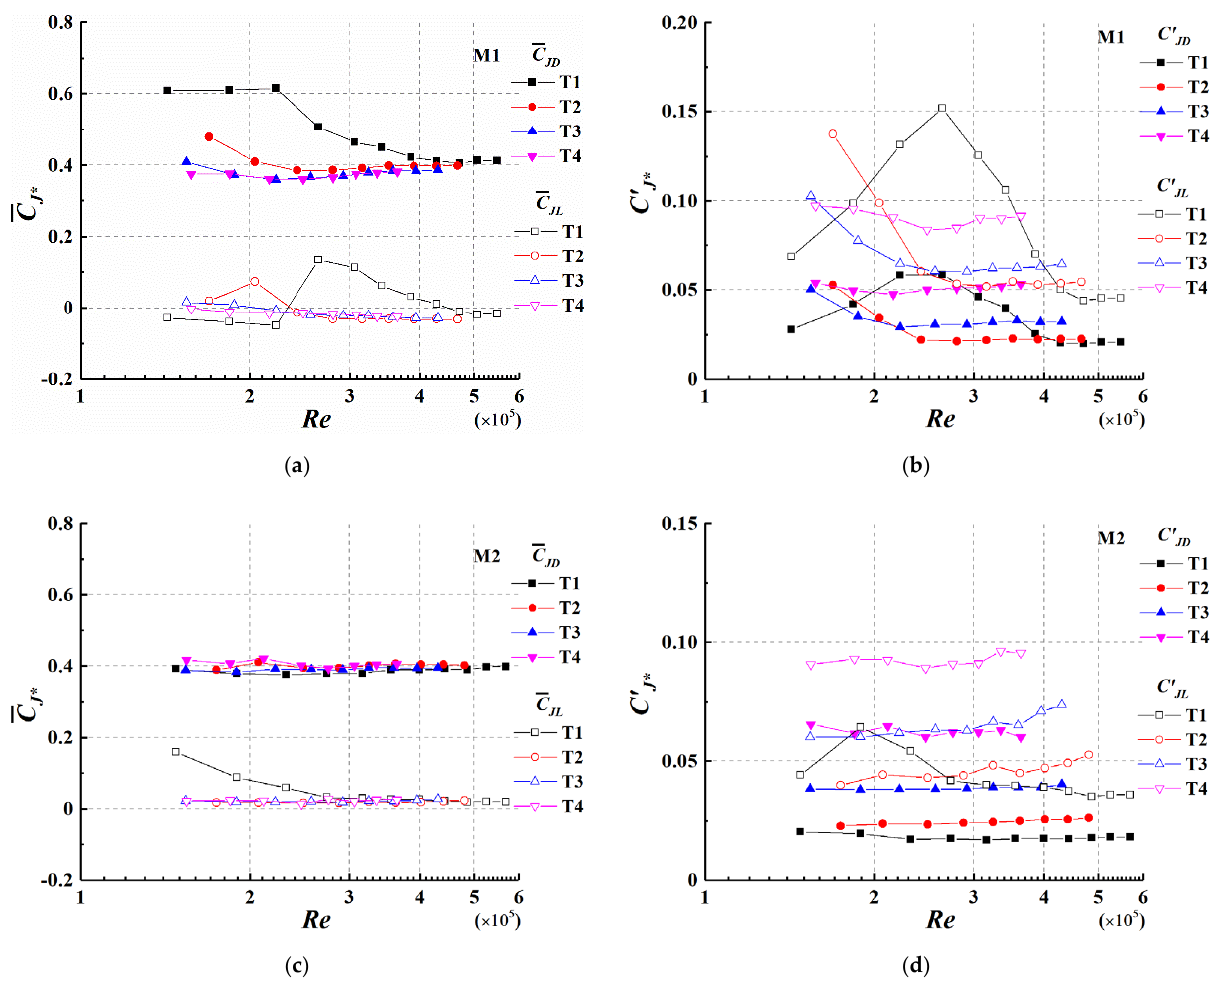
Figure 15. The variation of the base force coefficient of models with Re under different wind fields. ( a ) M1, the mean base force coefficient; ( b ) M1, the fluctuating base force coefficient; ( c ) M2, the mean base force coefficient; ( d ) M2, the fluctuating base force coefficient.